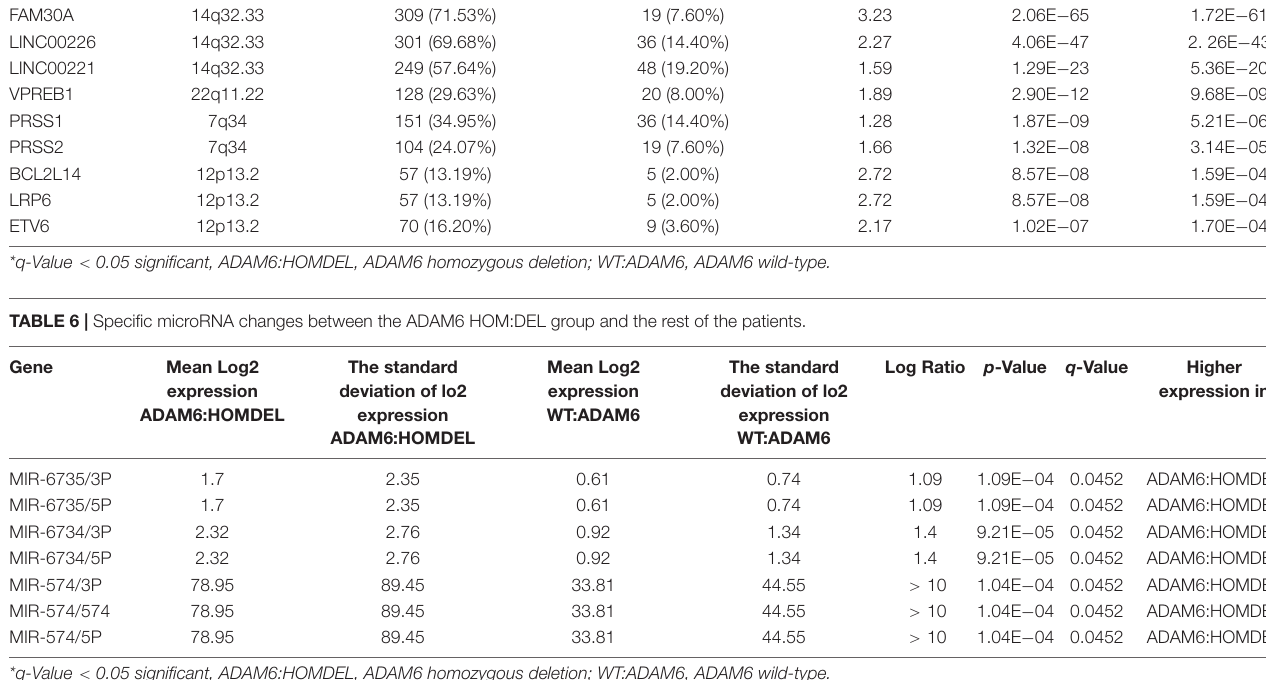
TABLE 5 | Most frequently deleted genes in ADAM6 homozygous deletion (ADAM6:HOMDEL) versus ADAM6 wild-type (WT:ADAM6) patients. Gene Cytoband (A) ADAM6:HOMDEL (B) WT:ADAM6 Log Ratio p -Value q -Value ADAM6